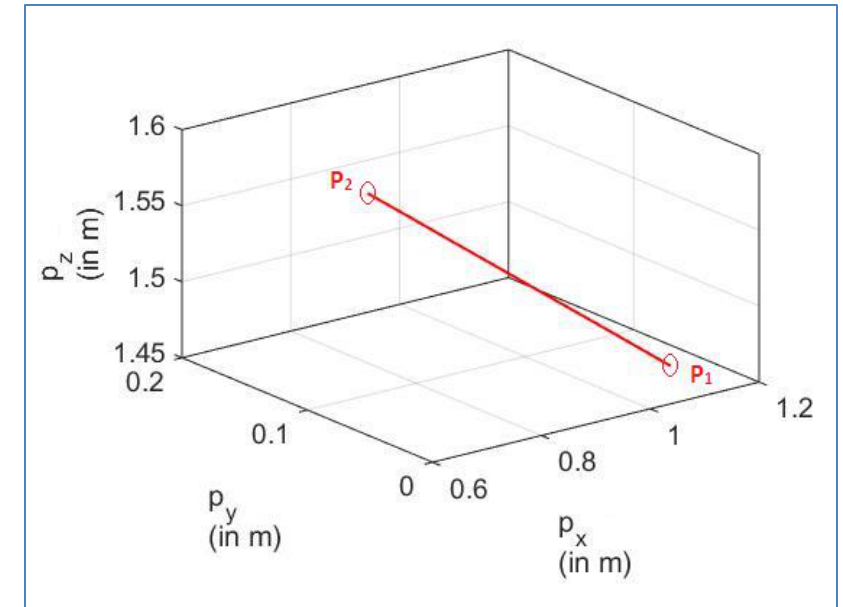
Figure 4. Mobile robot end-effector position